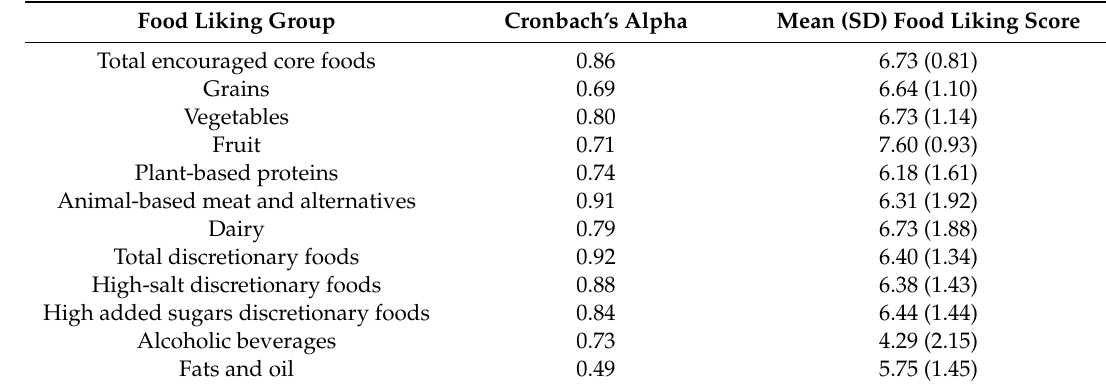
Table 2. Cronbach’s Alphas and mean food liking scores for encouraged core and discretionary foods in young Australian adults ( n =